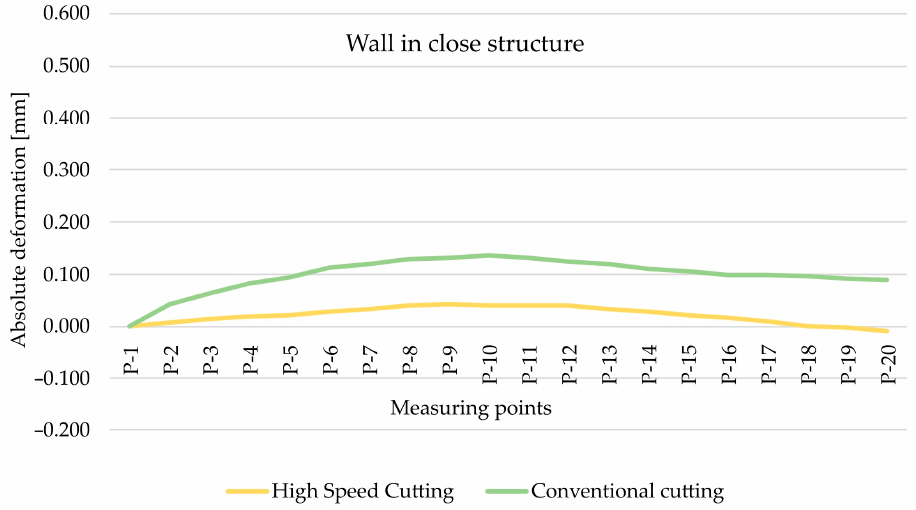
Figure 14. The comparison of absolute deformation for individual measurement points depending on the cutting type for the element with walls arranged in a closed structure made of the EN AW-6082 T651 aluminium alloy.